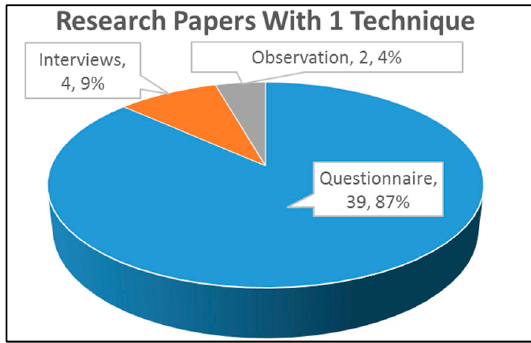
Figure 12. Papers with one main technique.